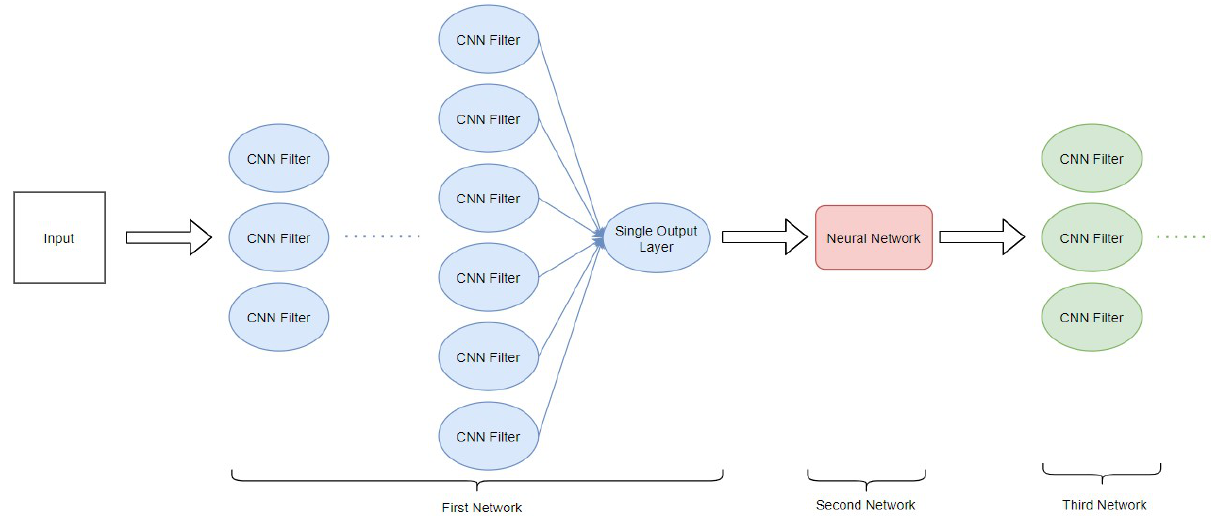
Figure 2. Network in network architecture